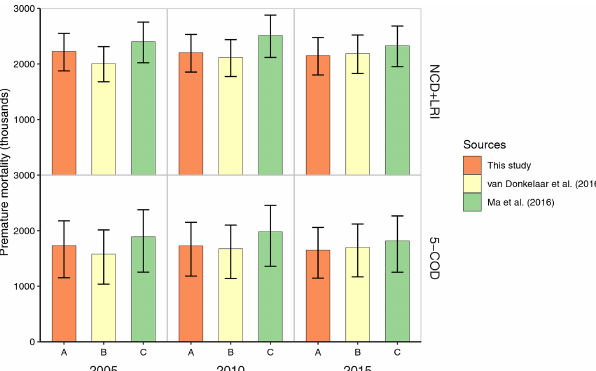
Figure 6. National PM 2 . 5 -related premature mortality estimated by PM 2 . 5 estimates from CMAQ simulations (this study) and satellite- based methods